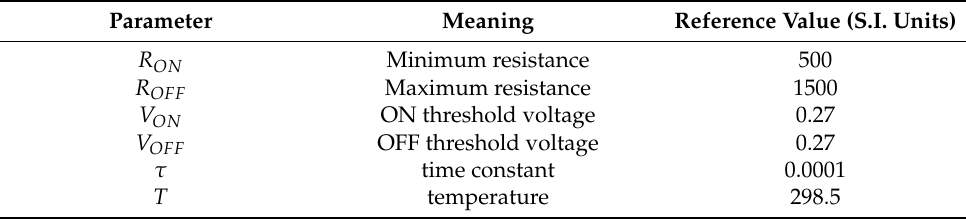
Table 1. List of parameters of the memristor model.